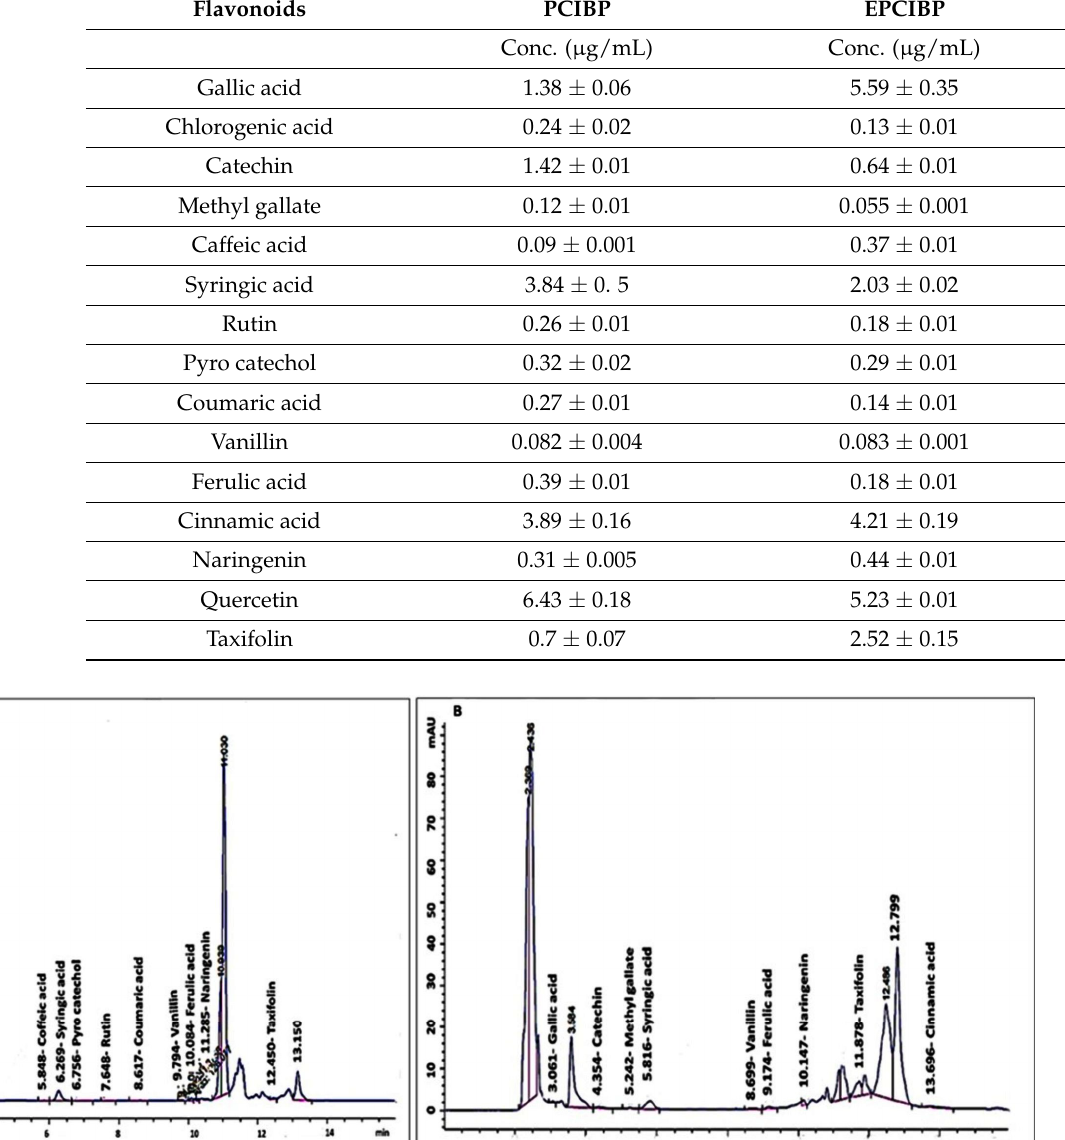
Table 1. Quantification and identification of flavonoid contents isolated from PCIBP and EPCIBP.